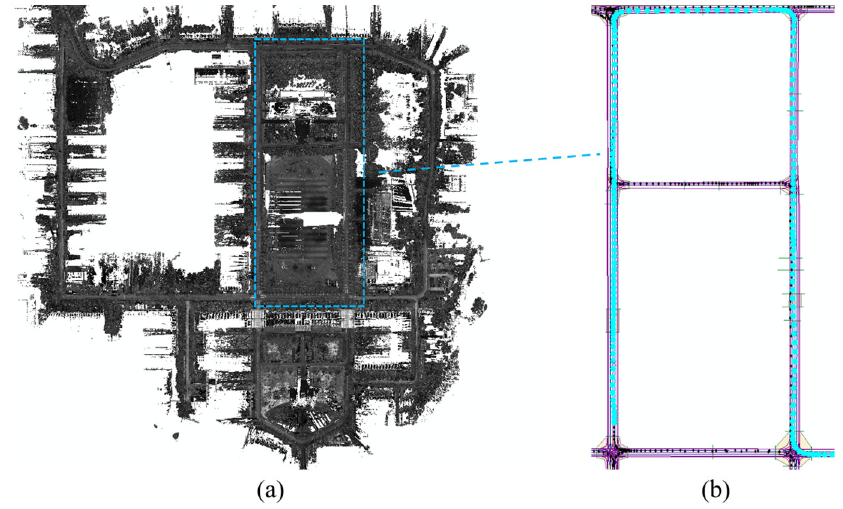
Figure 18. The algorithm efficiency experiment scene(a, b).